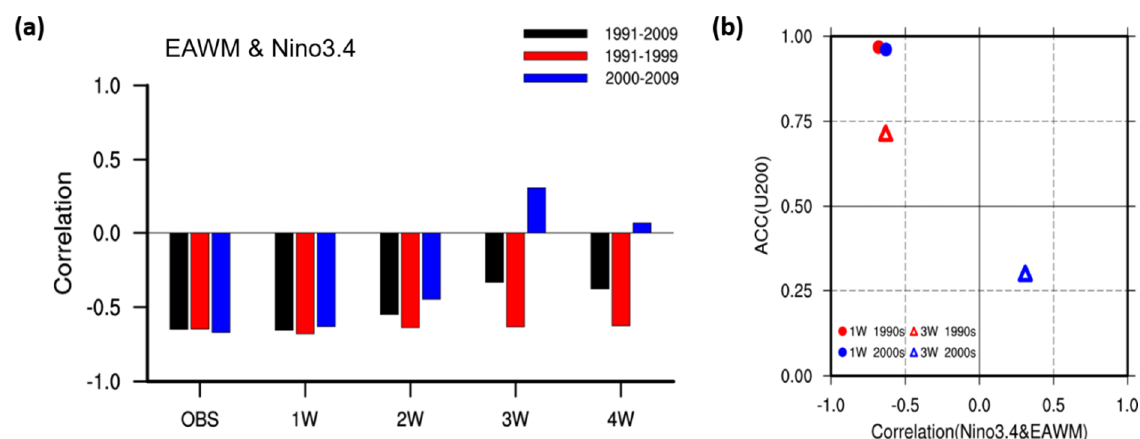
Figure 13. ( a ) Correlation coefficient between Nino 3.4 index and East Asia monsoon index from ERA–Interim and GloSea5 with lead times of 1–4 weeks. ( b ) Anomaly correlation coefficient of 200 hPa zonal wind over East Asia with Nino 3.4 and EAWM indices. Red bars are averaged for 1991–1999, blue bars are averaged for 2000–2009.